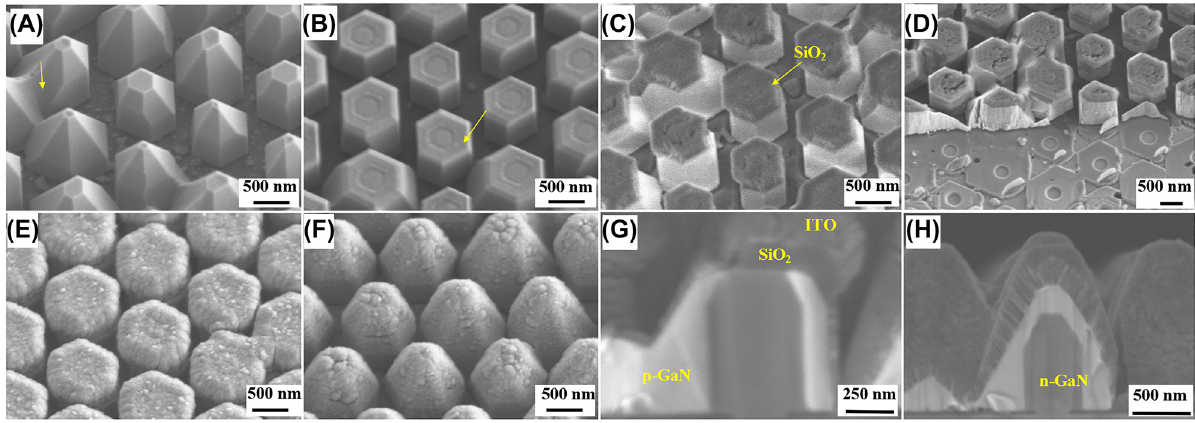
Figure 2: SEM characterizations of the NWs during fabrication process. Tilted-view SEM images for the (A) as-grown NW structures; (B) NWs with (0001) plane truncated by dry etching in samples d, e, and f; (C) NWs with SiO (D) exposed n-electrode region by ICP dry etching of NWs; (E) ITO deposition on samples d, e, and f; (F) NWs of samples a, b, and c covered by ITO. Cross-sectional view SEM images of the NWs (G) with and (H) without (0001) plane etching, wherein the p-GaN shell, SiO n-GaN core regions are marked.